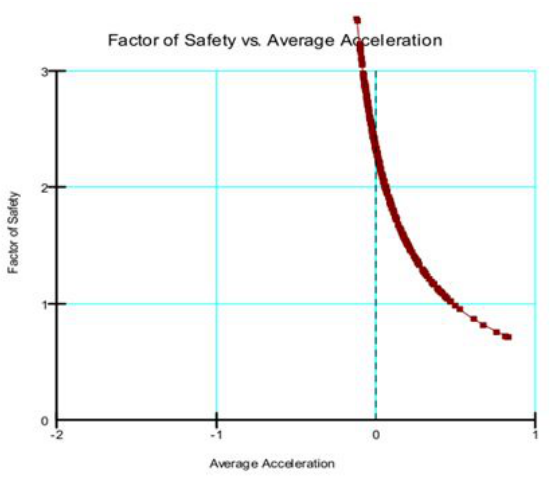
Fig. 7. Downstream Slope Factor of Safety vs Average Acceleration- Input Motion MCE-PETFN.